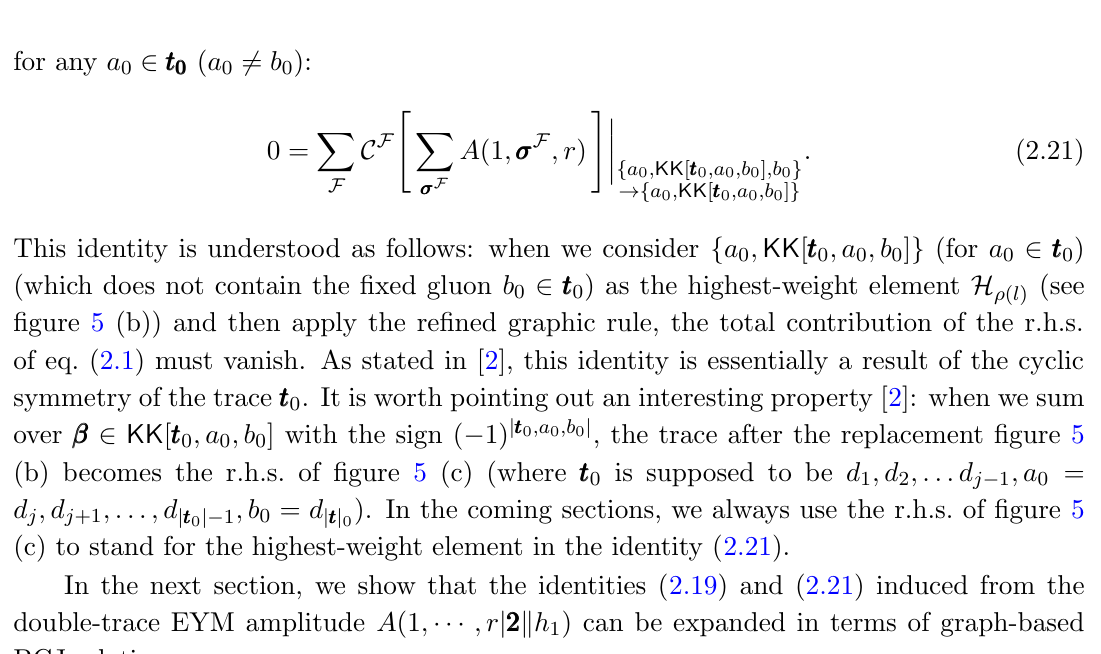
Figure 6 . Typical graphs for the identity induced from the double-trace amplitude A (1 ; 2 ; (cid:1) (cid:1) (cid:1) ; r j 222 k h 1 ) with the reference order R = f 222 ; h 1 g . The trace 222 plays as an internal trace in (a) and a starting trace in (b),